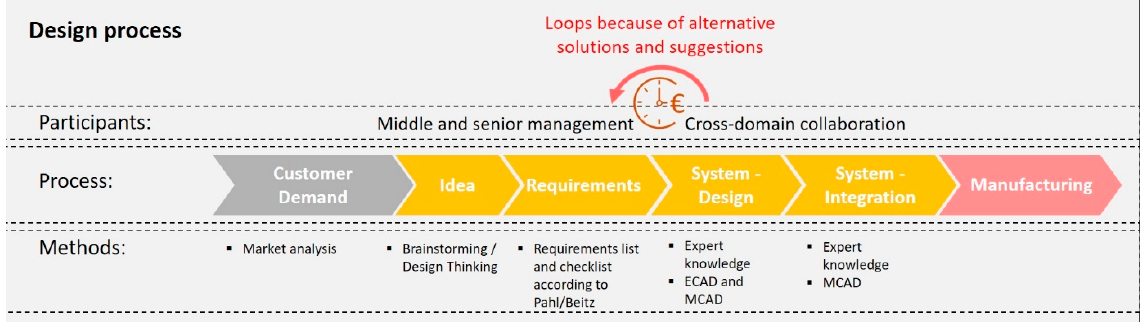
Figure 8. Implemented digital manufacturing process chain for iMMS.